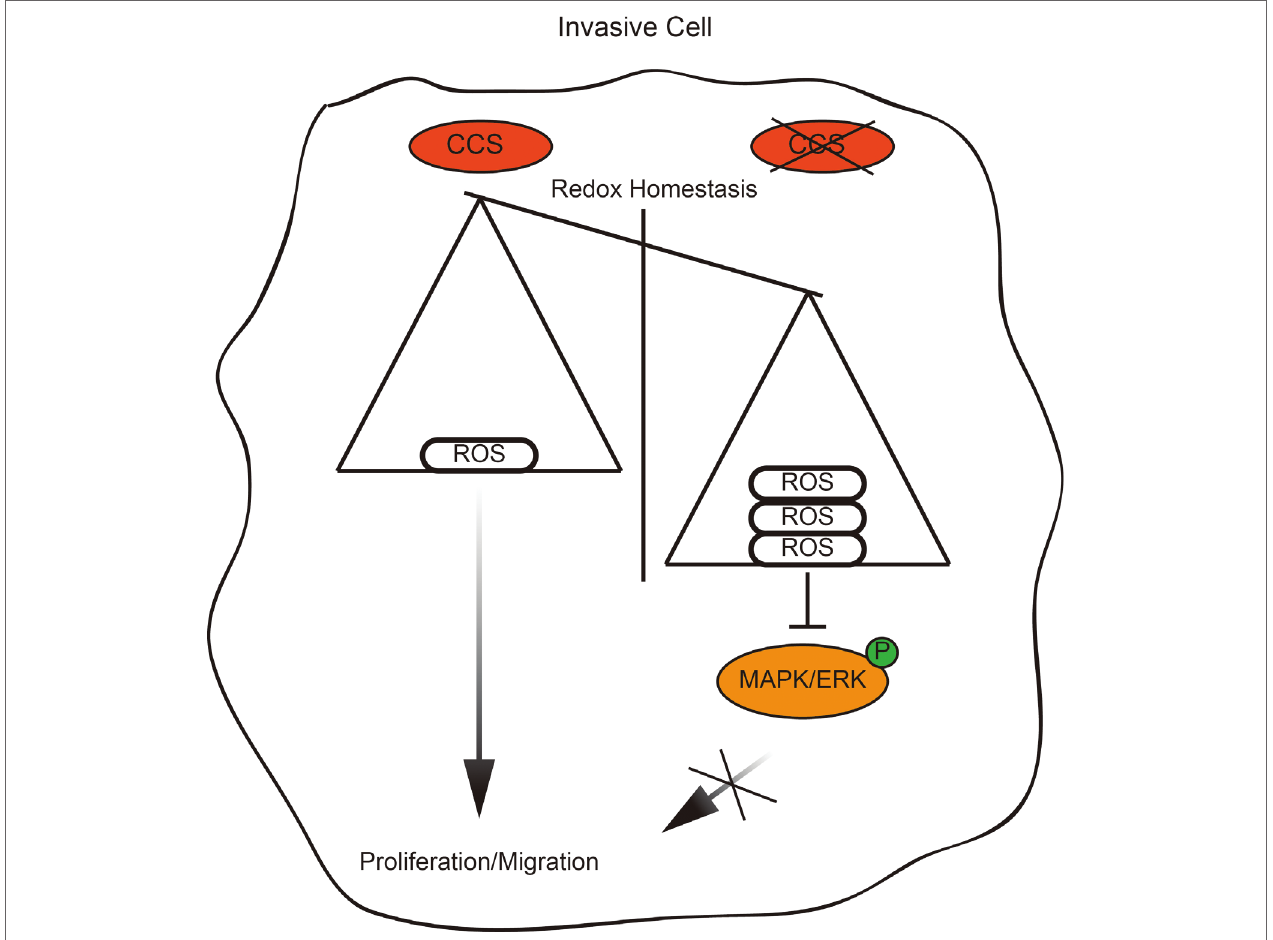
FIGURE 6 | Proposed working model. Schematic model shows that the role and mechanism of CCS in promoting breast cancer cell proliferation and